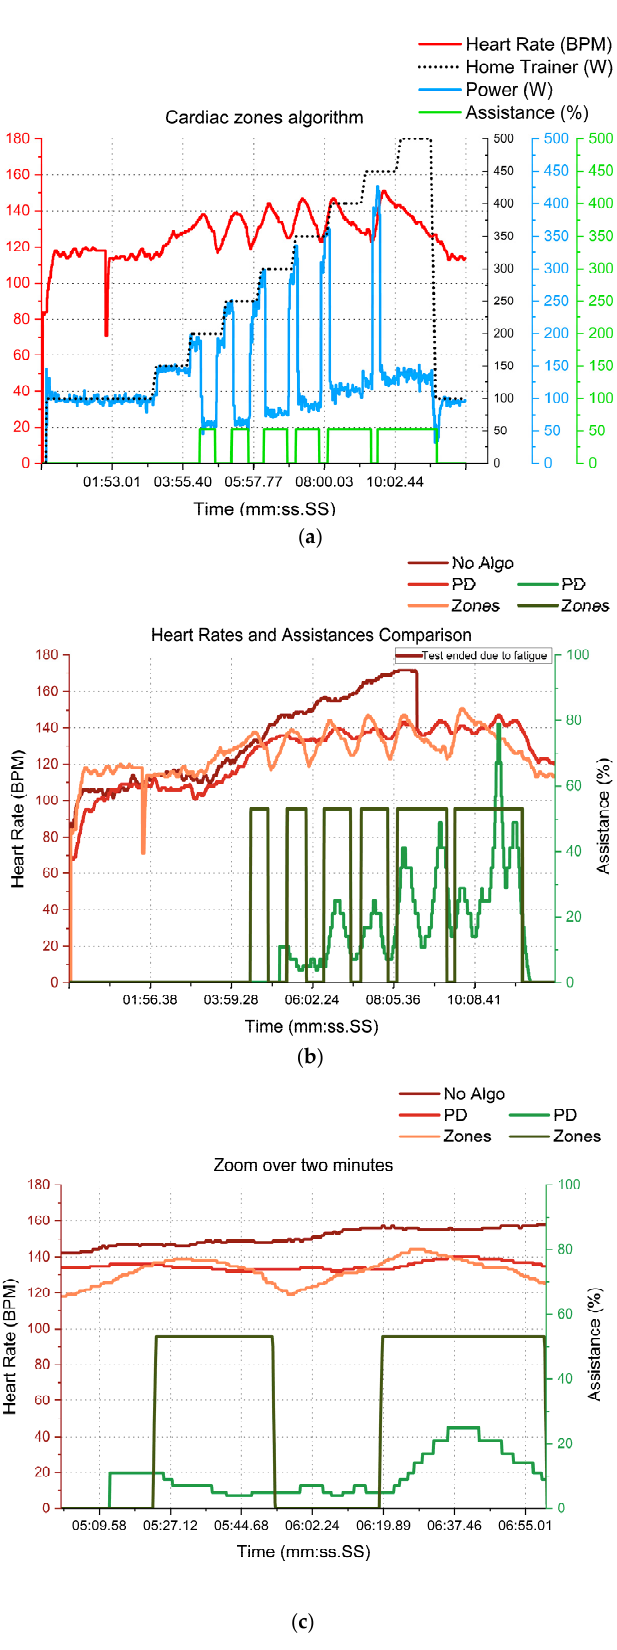
Figure 12. Example (N = 1) of 500 W test with the cardiac zone algorithm ( a ) and comparison with no assistance and PD outputs ( b , c ).